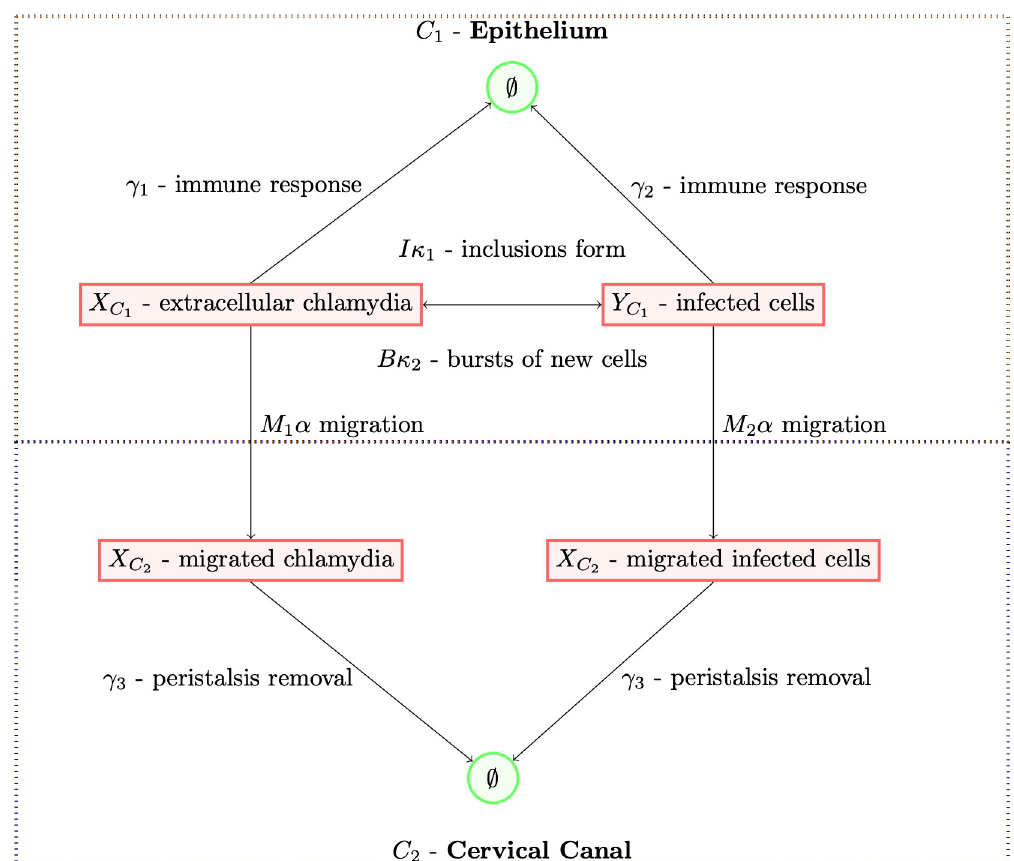
Fig 2. Flow diagram of the model. The figure outlines each component of the model that are incorporated in the analysis. Extracellular chlamydia can form inclusions to created new infected cells, and infected cells can burst to create new extracellular chlamydia. Both extracellular chlamydia and infected cells can be removed by the immune system, and be migrated to the cervical canal via the neutrophil response. In the cervical canal, infected cells can burst to create new chlamydia, but not vice versa. Extracellular Chlamydia and infected cells in the cervical canal be removed via peristalsis. The parameters of each component from the model are drawn from distributions that represent host and pathogen specific factors. The impact of each factor is represented as the proportion of simulations where the infection ascended for each parameter in the model in the following figures, out of a total of 252,500 simulations that were run.